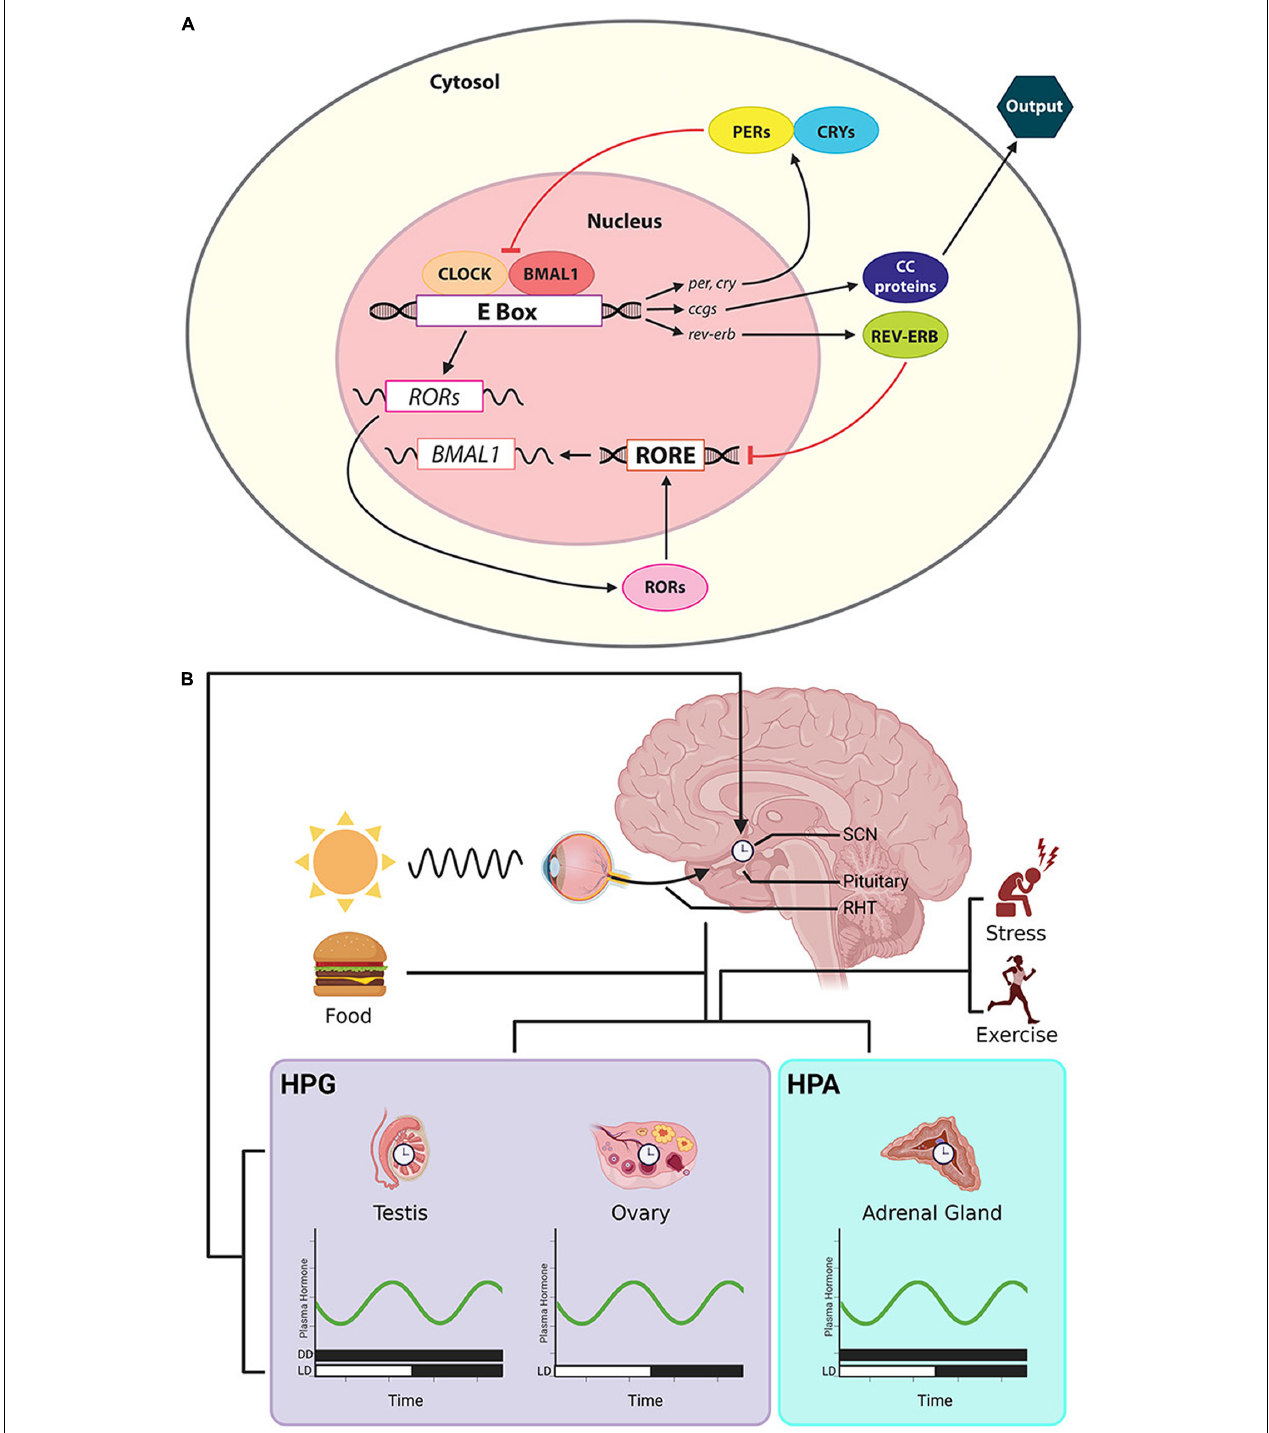
FIGURE 2 | Cellular/molecular clock, the CTS and rhythmic steroid production. (A) The cellular clock involves a primary loop controls the formation of dimer CLOCK/BMAL1. These proteins are translocated to the E-box of the promoter of per and cry , activating their transcription. PER and CRY proteins in turn suppress the translation of CLOCK/BMAL1. Orphan nuclear receptor genes, Rev-Erb α / β and ROR α / β , form a secondary transcriptional loop. REV-ERB and ROR protein compete for RORE at the promoter region of bmal1. REV-ERB suppresses bmal1 transcription and ROR activates it. The activities of these clock genes further regulate downstream ccgs and their protein products. (B) Output from the master clock in the SCN sends timing information to peripheral clocks in the